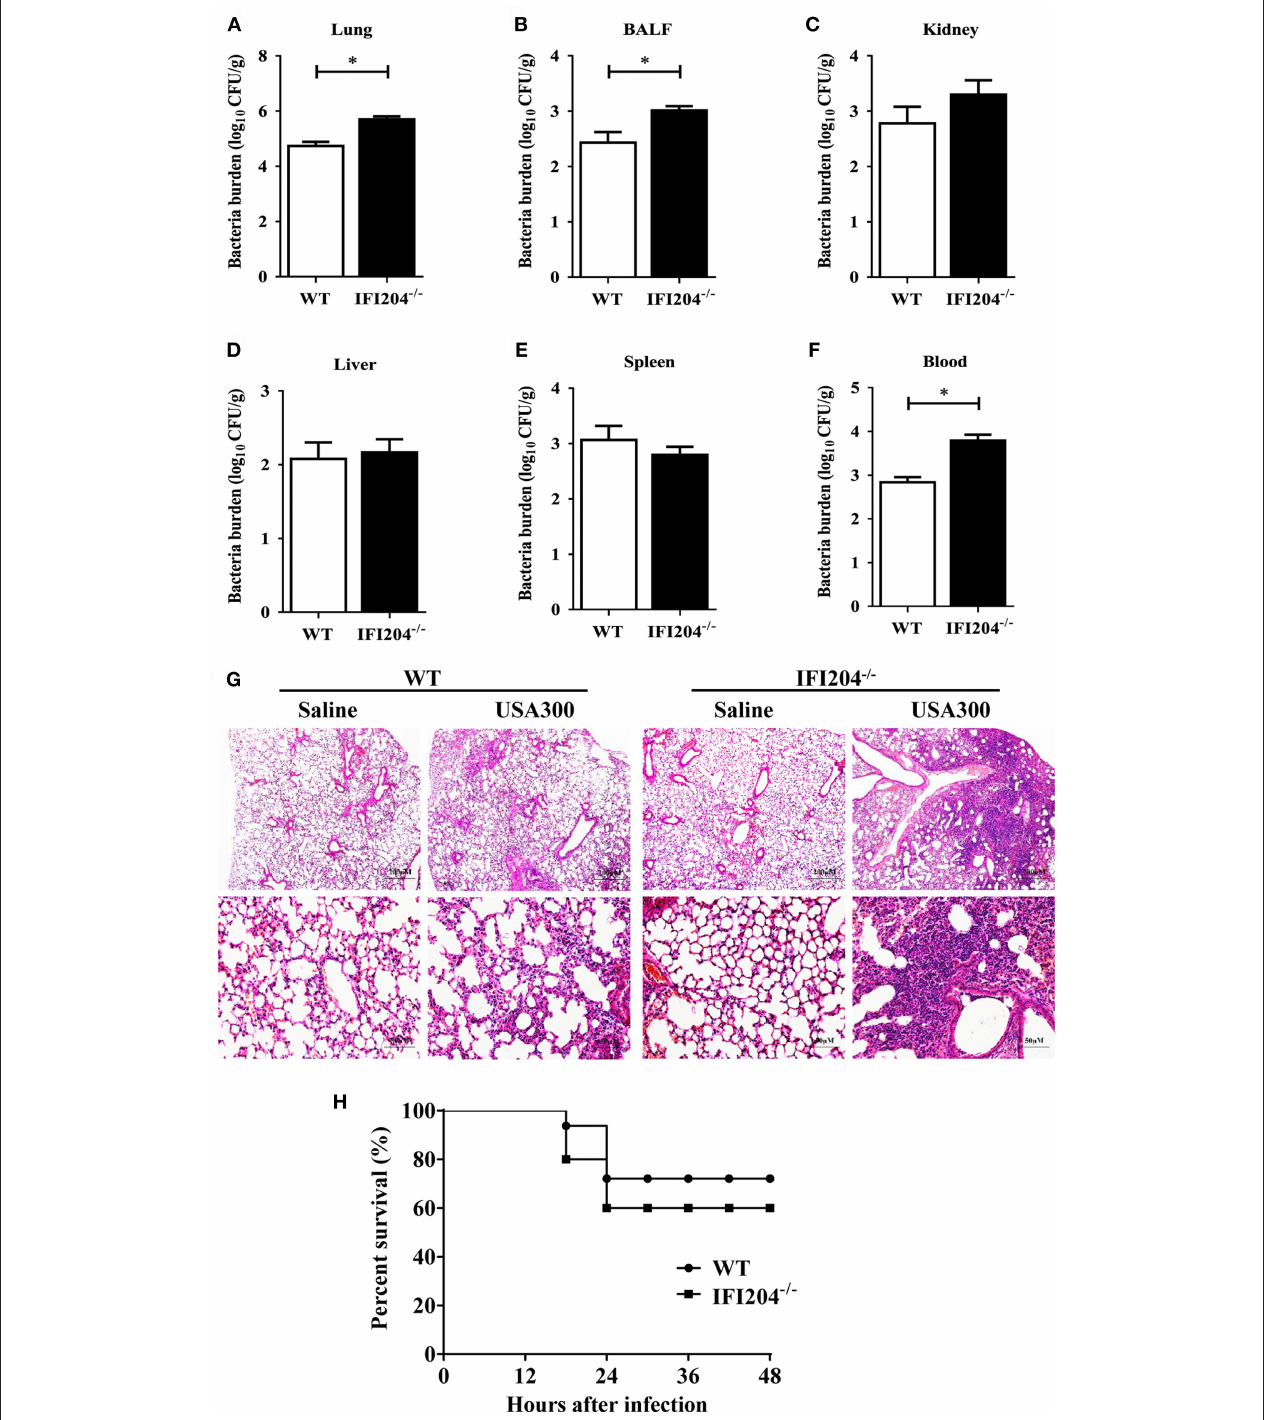
FIGURE 1 | Interferon-inducible protein 204 (IFI204)-deficient mice display increased susceptibility to Staphylococcus pulmonary infection. (A–F) Age- and sex-matched WT ( n = 8) and IFI204 − / − ( n = 10) mice were infected intranasally with 1 × 10 8 CFU of Staphylococcus . Homogenized tissues, BALF and blood were subjected to plating serial dilution for bacterial loads at 16 hpi. All data are shown as mean ± SEM. Student’s t -test was performed. * p < 0.05. (G) Hematoxylin-eosin staining of lung tissues collected from WT and IFI204 − / − ( n = 5 each group) mice at 48 hpi. Magnification 40 × or 200 × . (H) WT and IFI204 − / − mice were inoculated intranasally with 2 × 10 8 CFU of Staphylococcus ( n = 15) or PBS ( n = 13). The animals were monitored every 6h up to 48h for survival.